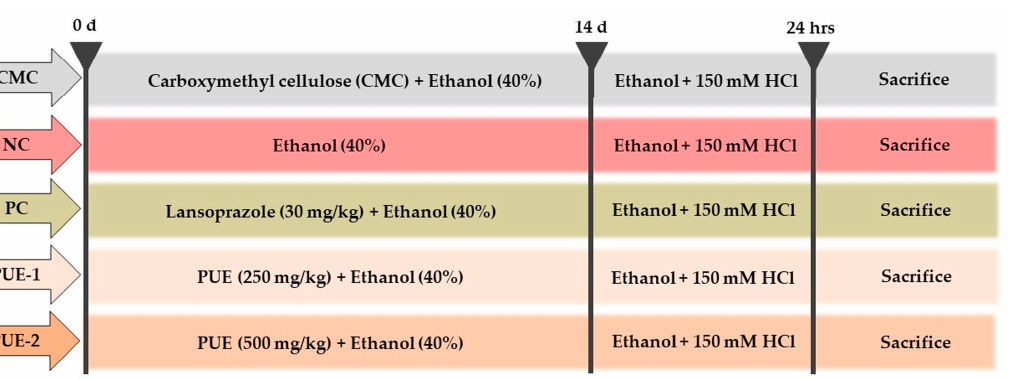
Figure 1. In vivo experimental design for ethanol-induced gastritis in rats. The Pyrus ussuriensis Maxim extract (PUE) was administered orally prior to the ingestion of ethanol (40%) for 14 days once a day. Then, 1 h before sacrifice, the rats were administered 70% ethanol in 150 mM HCl. For these experiments, Lansoprazole (30 mg/kg) was used as positive